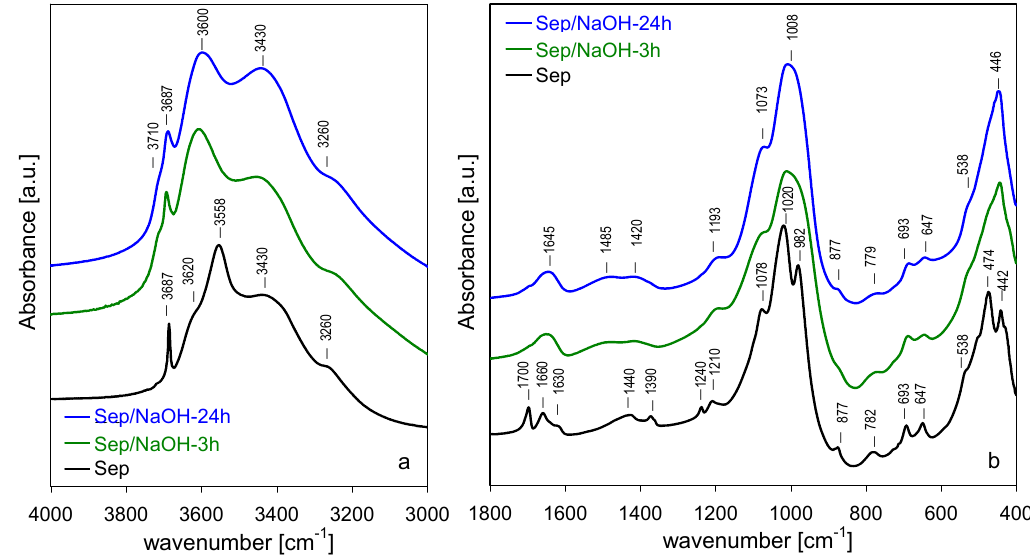
Figure6. EvolutionofFTIRspectraforsepiolitetreatedwithNaOHat90 ◦ C,timeeffect: ( a )3000–4000cm − 1 , ( b ) 400–1800 cm − 1 . Figure 6. Evolution of FTIR spectra for sepiolite treated with NaOH at 90 °C, time effect: (a) 3000– 4000 cm − 1 , (b) 400–1800 cm − 1 .